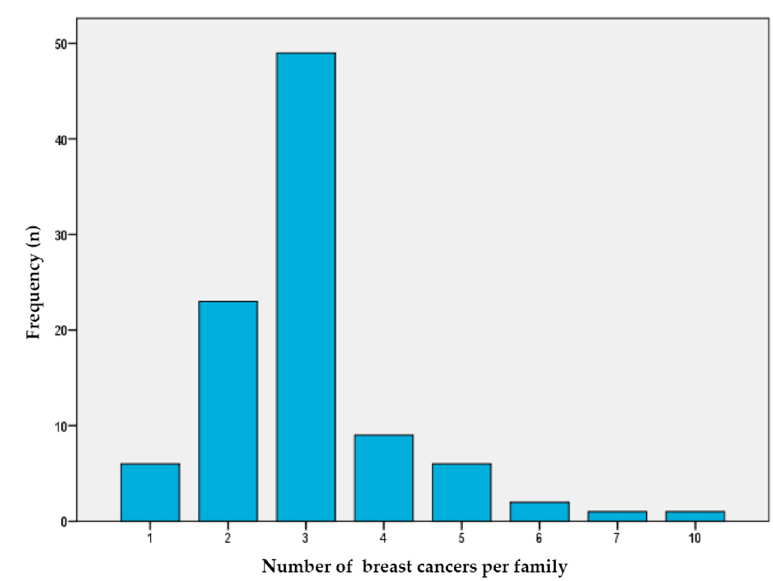
Figure 1. Number of breast cancer cases per family. This figure shows the number of breast cancer per family (X axis) that each index case in the study presents (Y axis).